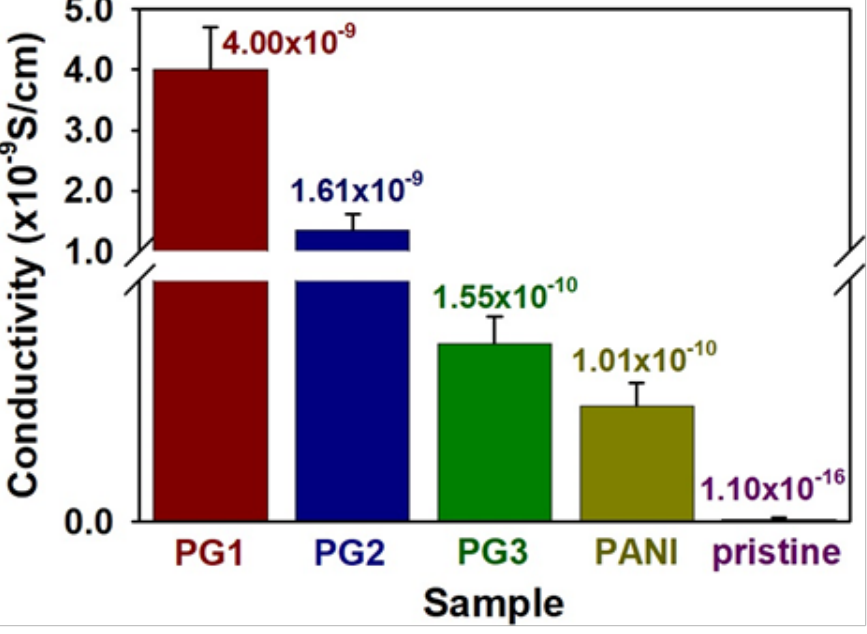
Figure 5. Electrical conductivity of pristine polyacrylate and composites employing conductive fillers: PANI (5 wt % PANI NFs), PG1 (5 wt % PANI and 1.2 wt % graphene), PG2 (5 wt % PANI and 0.6 wt % graphene), PG3 (5 wt % PANI and 0.3 wt % graphene).